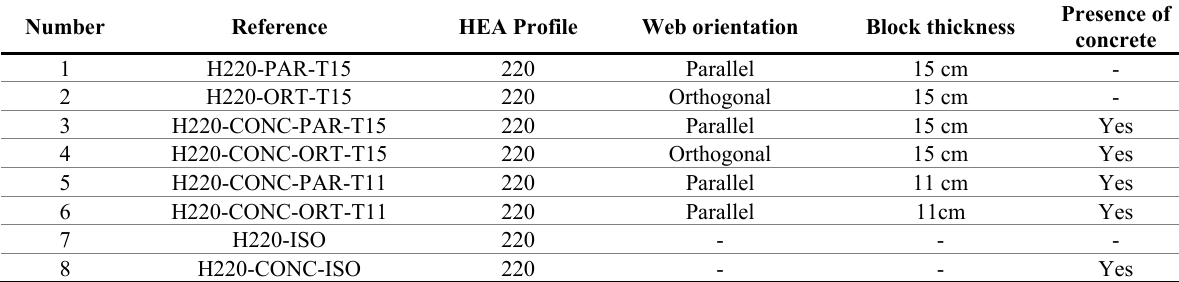
Table 1. Characteristics of the columns used in the numerical modeling.